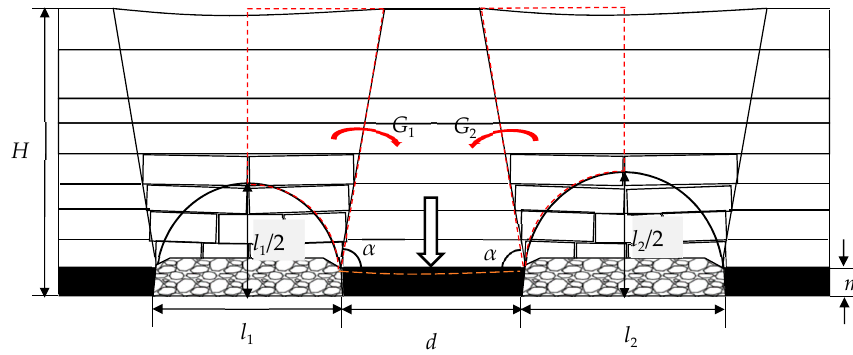
Figure 7. Estimation model of mining-induced compression amount of the isolated coal pillar.